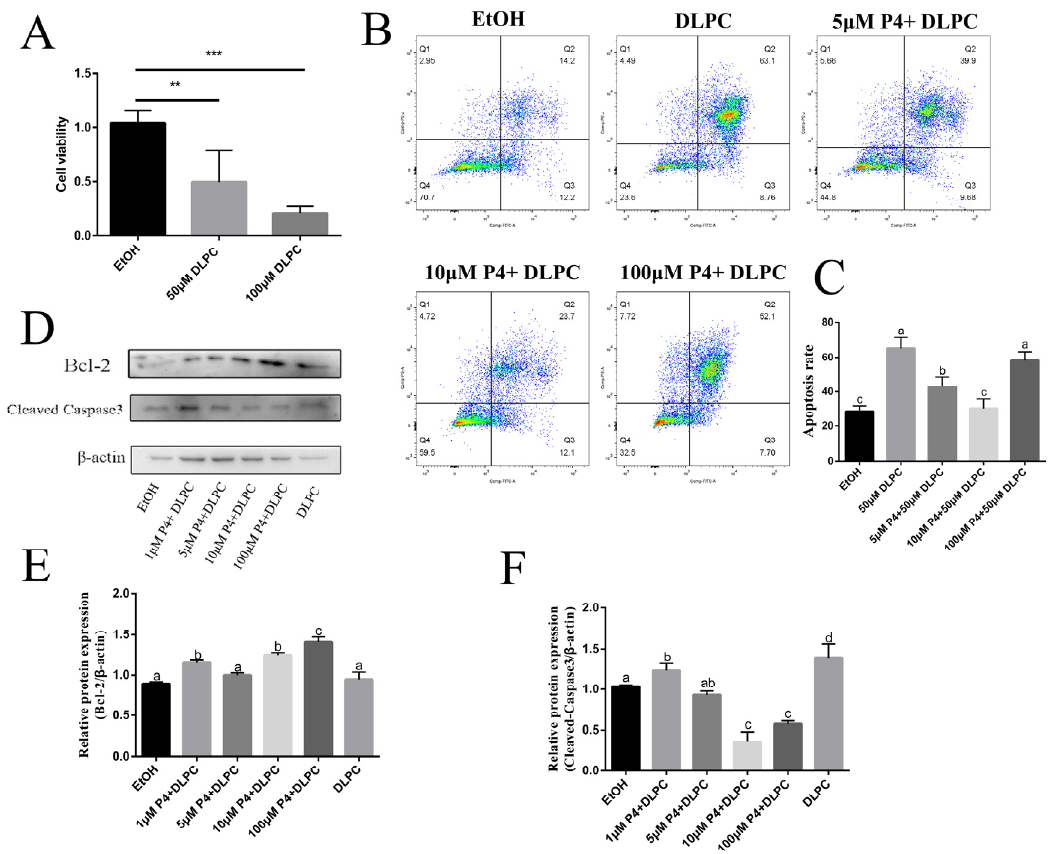
Figure 4. DLPC activation promoted apoptosis via progestogen signaling. ( A ) The viability of granulosa cells was shown by CCK-8 assay in different treatments. ( B ) Representative images of apoptosis with annexin V-FITC staining by a flow cytometry instrument in 50 µ M DLPC-, 50 µ M DLPC + 5 µ M P4-, 50 µ M DLPC + 10 µ M P4-, 50 µ M DLPC + 100 µ M P4-exposed granulosa cells. ( C ) The percentage of apoptosis in the different treatment groups. ( D ) Western blotting of Bcl2 and cleaved-caspase 3 in granulosa cells by treatment with 50 µ M DLPC, 50 µ M DLPC + 1 µ M P4, 50 µ M DLPC + 5 µ M P4, 50 µ M DLPC + 10 µ M P4 and 50 µ M DLPC + 100 µ M P4, respectively. ( E , F ) The ratios of Bcl-2 to β -actin, cleaved-caspase 3 to β -actin expression were normalized, and the values were shown, respectively. Data are shown as the means ± SEM of three biological replicates. Values with different letters (a, b, c) indicate significant differences in bars ( p < 0.05). ** p < 0.01, *** p < 0.001, comparing the indicated groups.